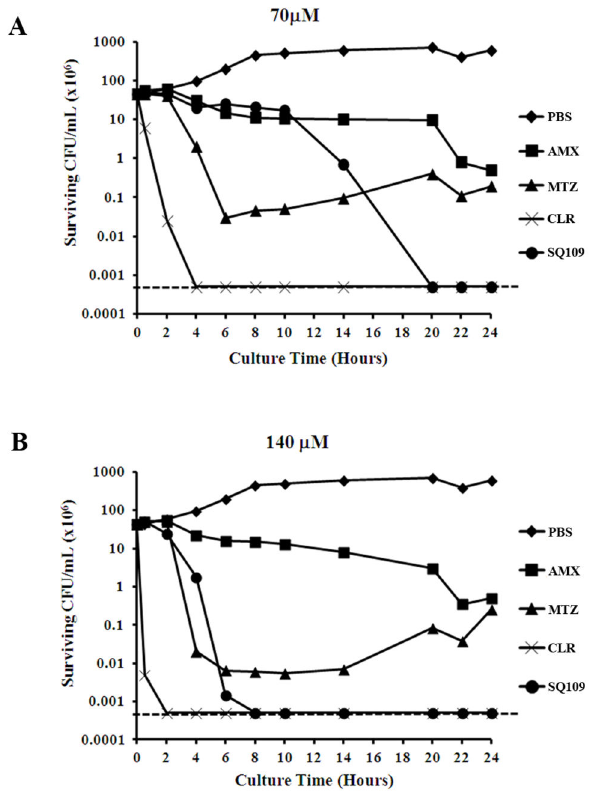
Table 3. H. pylori frequency of resistant mutants to SQ109.